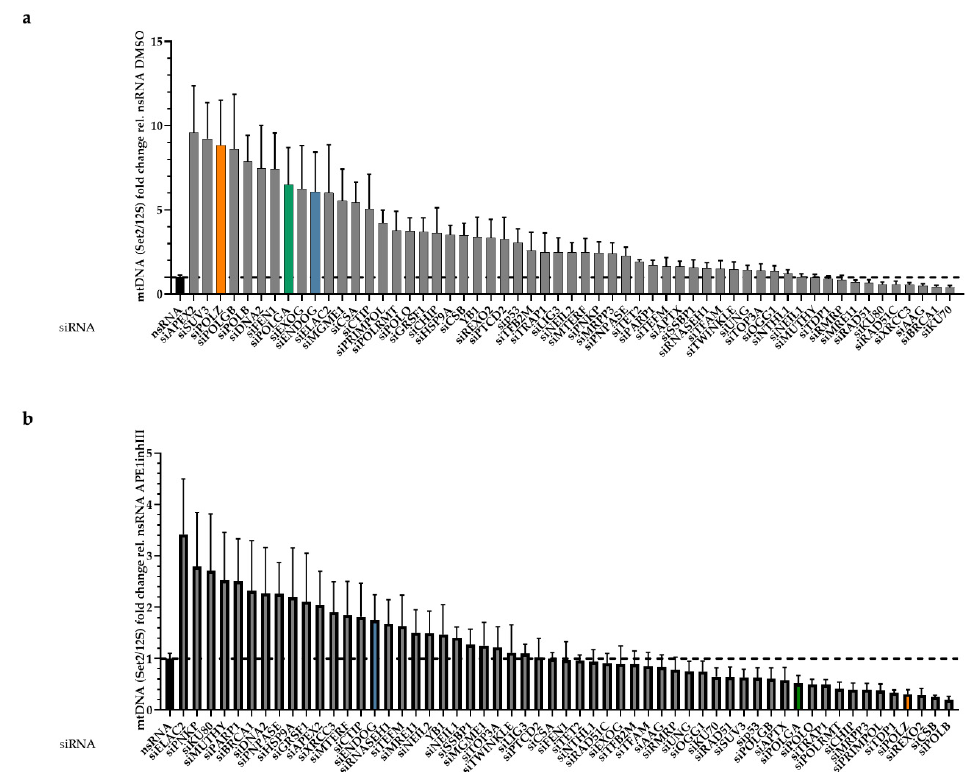
Figure 2. Waterfall plot of mtDNA changes in the siRNA screen. HeLa cells were grown in galactose medium and subjected to siRNA-mediated knockdown of the indicated candidate proteins associated with mitochondrial functions for 48 h. Cells were treated with DMSO ( a ) or 15 µM APE1inhIII ( b ) for 5 h. PCR products of the 7 kb long Set2 mtDNA region amplified from total DNA were quantified, normalized to the sample-specific values for the 0.2 kb short mitochondrial 12S region and plotted relative (rel.) to the mean values for nsRNA transfected samples per experiment ( n = 6–8 from 4 independent experiments). All values are means ± SEM. Note that colored bars indicate data obtained after knockdown of high priority factors of this study further on, namely blue bars after ENDOG knockdown, green bar after POLGA knockdown, and orange bar after POLZ knockdown. To obtain better insight into the results of the siRNA screening, the investigated pro- teins were grouped according to the pathway in which they are involved and/or their biochemical functions, and compared to all other investigated proteins. Of note, the aver- age values obtained for the group of DSB repair proteins were remarkably lower than the other proteins, whereas they were higher for the groups of polymerases and nucleases (Figure 3a). For all other functional groups, no significant differences were observed. To further delineate the impact of individual proteins in the three groups with identified dif- ferences in Set2 mtDNA content, the mean values obtained after knockdown of single